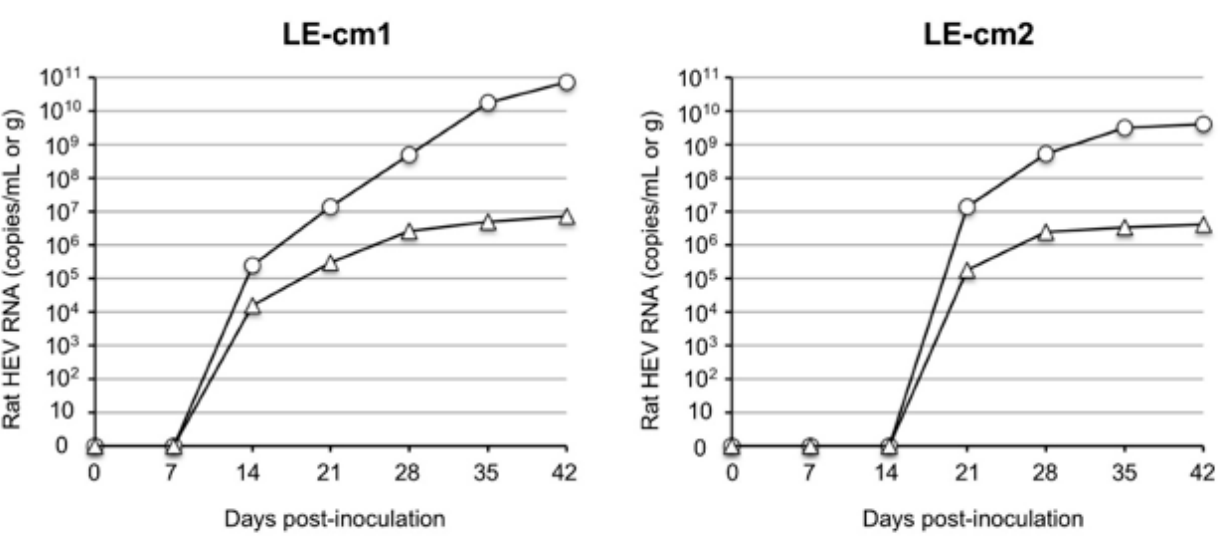
Figure 2. Infectivity of rat HEV recovered from the cynomolgus monkey. Two nude rats (LE ‐ mc1 and LE ‐ mc2) were intravenously inoculated with 0.5 mL of 10% stool suspension containing 5.2 × 10 4 copies/mL of strain V ‐ 105 collected from monkey M4833 on day 19 p.i. The copy numbers of the virus RNA in fecal specimens ( ) and serum ( ) were measured by RT ‐ qPCR.